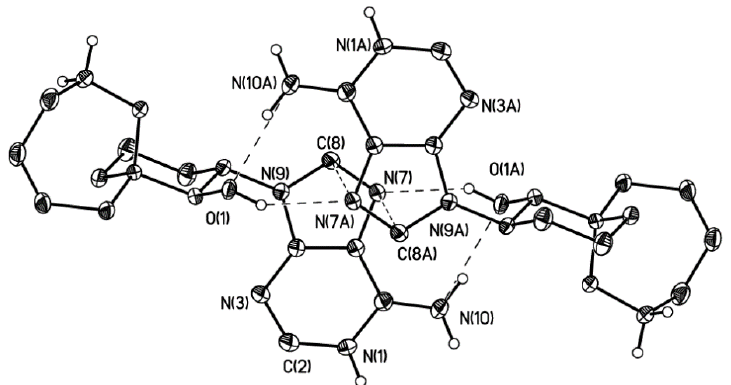
Figure 2. Centrosymmetric tetracationic dimer in crystal 3 (hydrogen atoms of C-H groups are not shown).